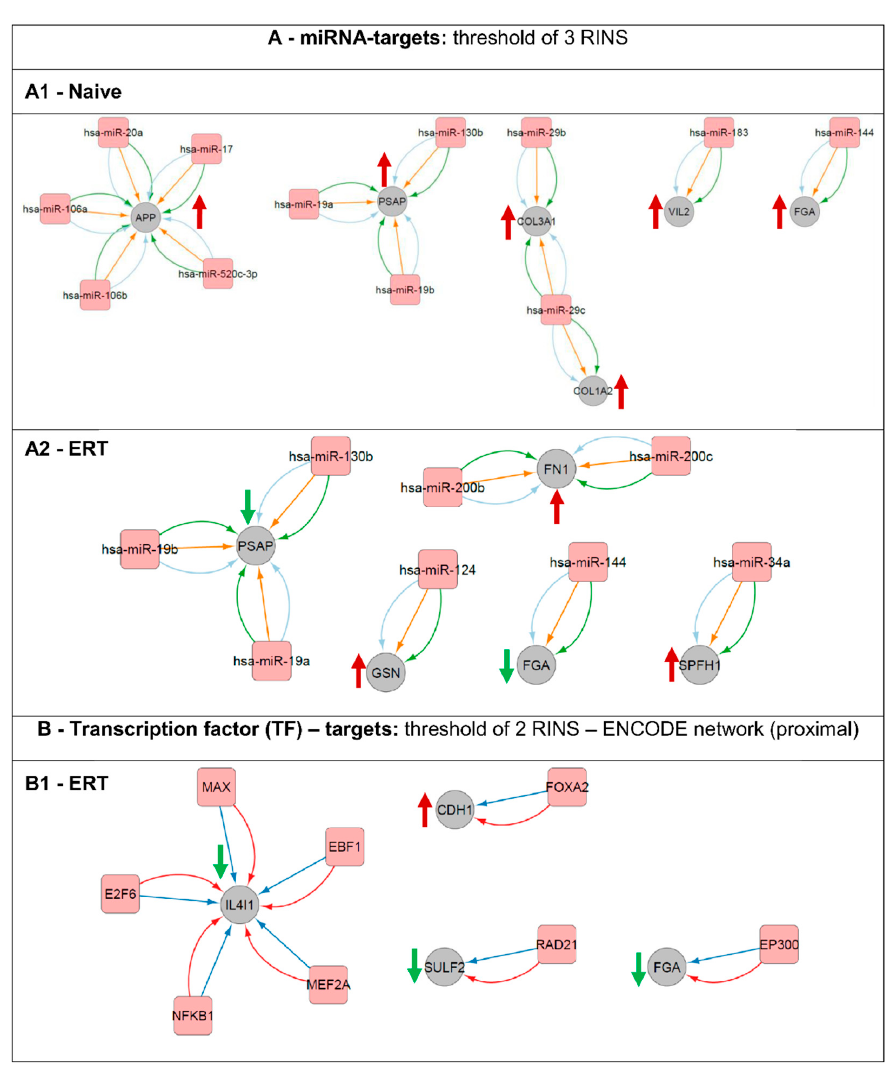
Figure 7. Regulatory network interactions of putative gene transcription regulators and their respective targets. Analysis was done based on miRNA-targets ( A ) and transcription factors ( B ). ( A1 ) miRNA-targets for the naïve group. ( A2 ) miRNA-targets for the ERT group. ( B1 ) transcription factor (TF)-targets for the ERT group. An arrow’s colour and direction indicates the regulation trend of the target molecules (green: down-regulated; red: up-regulated). The naïve group regarding the TF-targets did not fulfil the minimum requirement of two RINS in the CyTargetLinker app analysis thereby is not displayed here.